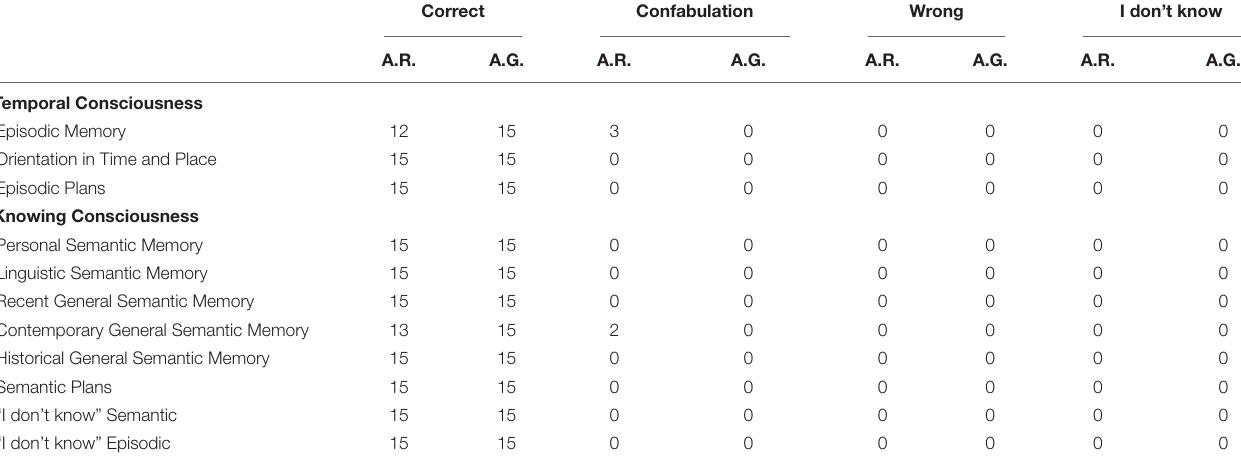
TABLE 2 | A.R. and A.G.’s performances on each of the 11 domains of the Confabulation Battery assessed at T3 visit. Correct